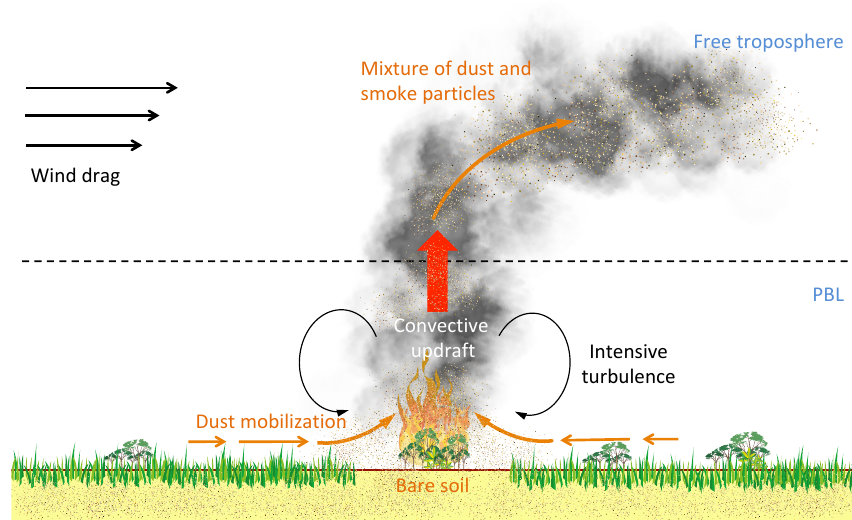
Figure 1. Schematic overview of the conceptual model of fire-driven emissions of mineral